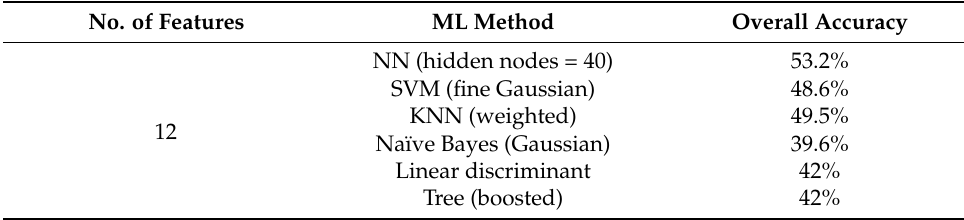
Table 5. Performance of the best OST prediction systems, using radiomic features based on mid- horizontal plane and various ML